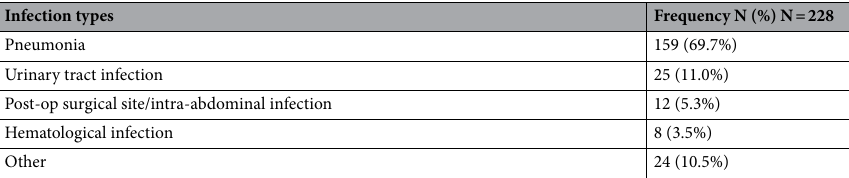
Table 2. Infection types. *Other: fungal infections, tibial infection, pleural cavity infection/empyema, Clostridioides difficile diarrhea and colitis, soft tissue infection, corneal infection.